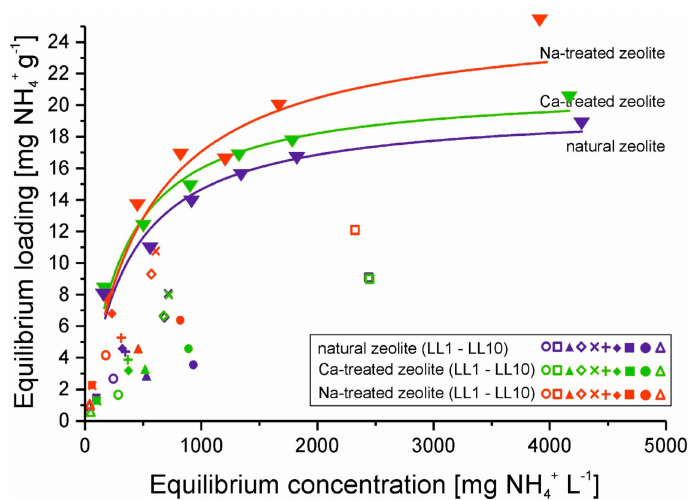
Figure 3. Adsorption isotherms (lines and triangles) of zeolites with di ff erent cation loading (blue: natural loading, green: Ca loading, red: Na loading) and equilibrium loadings and concentrations from experiments with landfill leachates (spots).